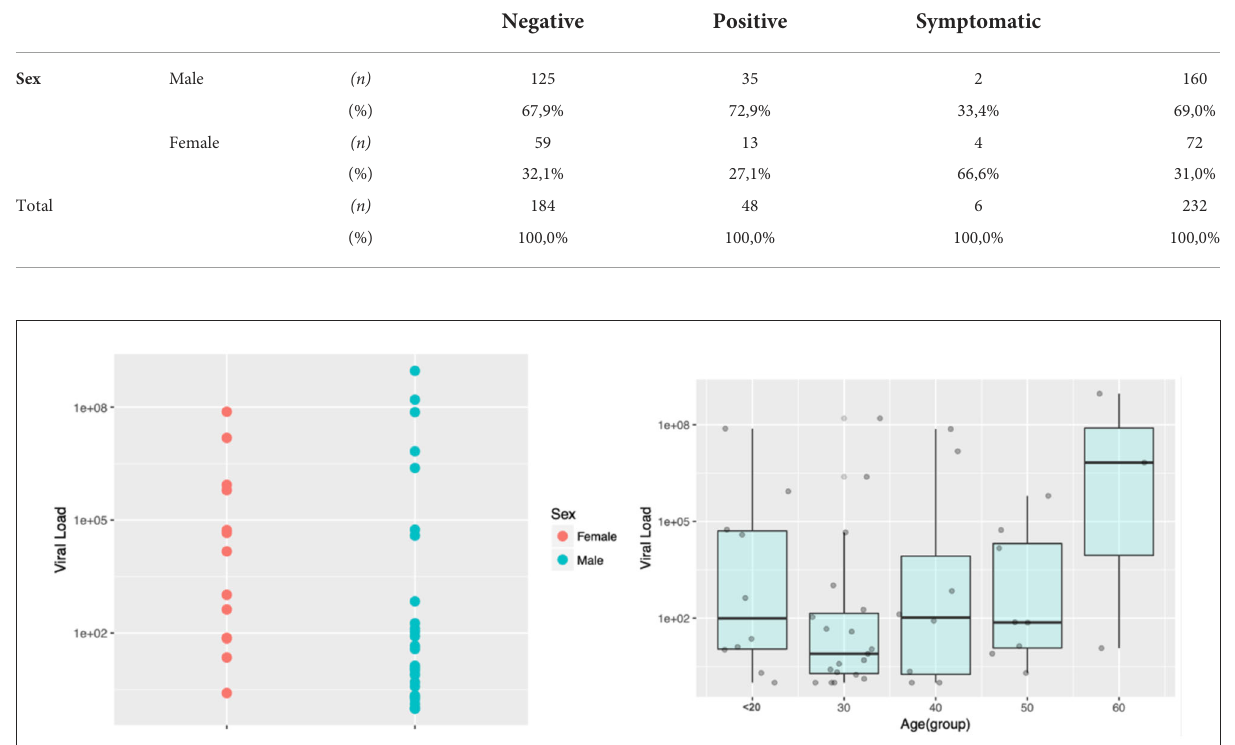
FIGURE2 SARS-CoV-2 viral load distribution in the study population according to sex and age categories. Viral load is displayed in the log